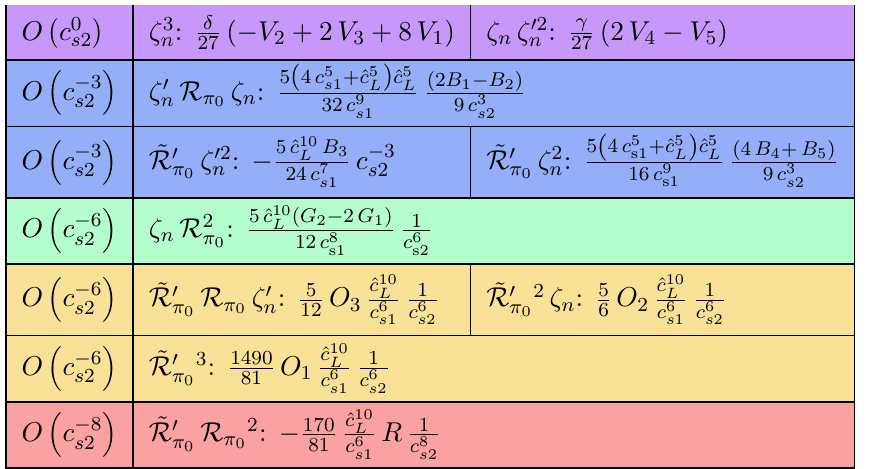
Table 3 . Bispectrum of ζ n : f NL for an equilateral configuration and c s 2 (cid:28) 1